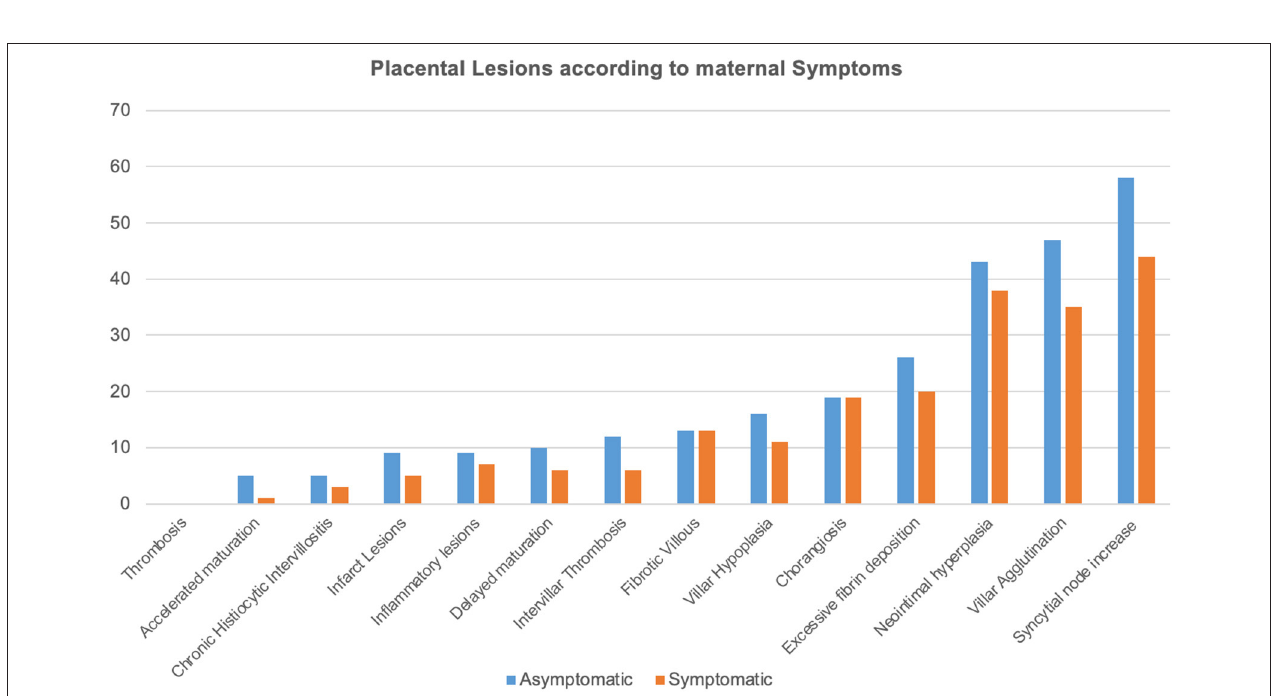
FIGURE 2 | Histopathological lesions are illustrated according to each frequency and to maternal symptoms as SARS-CoV-2 related symptoms included body temperature > 37.5 ◦ C, dyspnea, cough, hyposmia, ageusia, and diarrhea. Histopathological findings were reported according to Benton et al. (18).